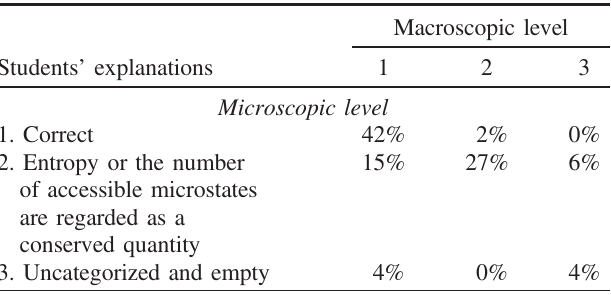
TABLE VI. Cross tabulation of students ’ explanations regard- ing changes in the entropy and in the number of accessible microstates for the combined systems of two entities undergoing the heat transfer process (items 1c and 2c). N ¼ 48 . Categories 1 – 3 are the same in columns and rows but for macroscopic (columns) and microscopic (rows) levels.